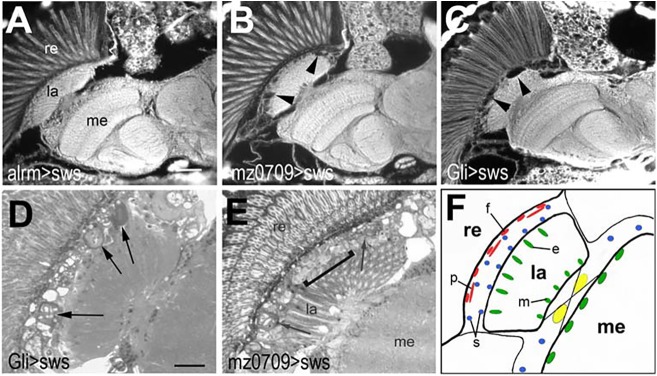
SWS is required in lamina glia. Paraffin head sections of 14-day-old flies show that inducing the swsGD RNAi construct with alrm-GAL4 does not cause vacuolization in the lamina cortex (A), whereas the knockdown via mz0709-GAL4 (B, arrowheads) or Gli-GAL4 (C, arrowheads) does. Analyzing plastic sections, we found the membranous structures in 14-day-old Gli-GAL4;swsGD (D, arrows) and mz0709-GAL4;swsGD (E, arrows) flies, but the phenotype was weaker in the latter, with some parts of the lamina cortex still unaffected at this age (E, bracket). (F) Schematic showing the glial subtypes of the lamina. The fenestrated (f) and pseudocartridge (p) glia belong to the surface glia (red), the inner and outer satellite glia (s) to the cortex glia (blue), the epithelial glia (e) and marginal glia (m) to the neuropil glia (green). The chiasma glia is shown in yellow. Scale bar in A: 25 µm, in D: 12 µm. re, retina; la, lamina; me, medulla.